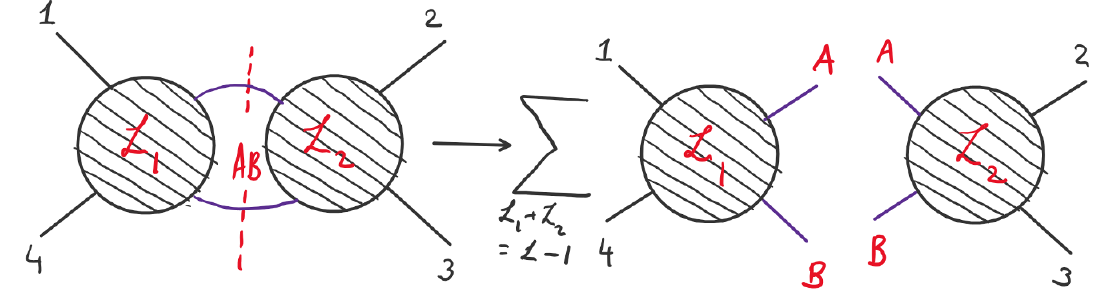
Figure 3 . Structure of the unitarity cut at 4